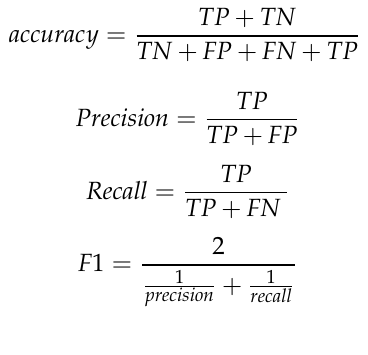
Table 6. The relevant parameters.